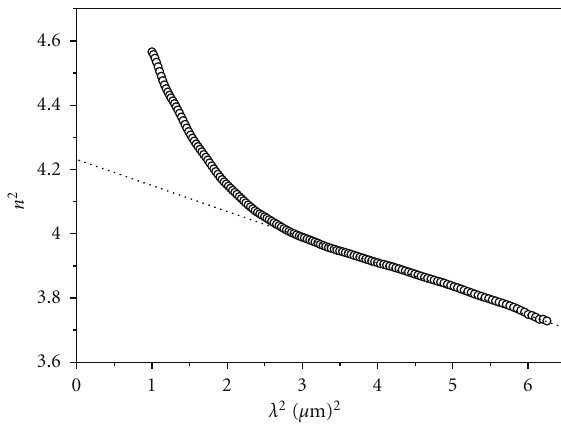
Figure 7: n 2 versus λ 2 for the PTDCI films.